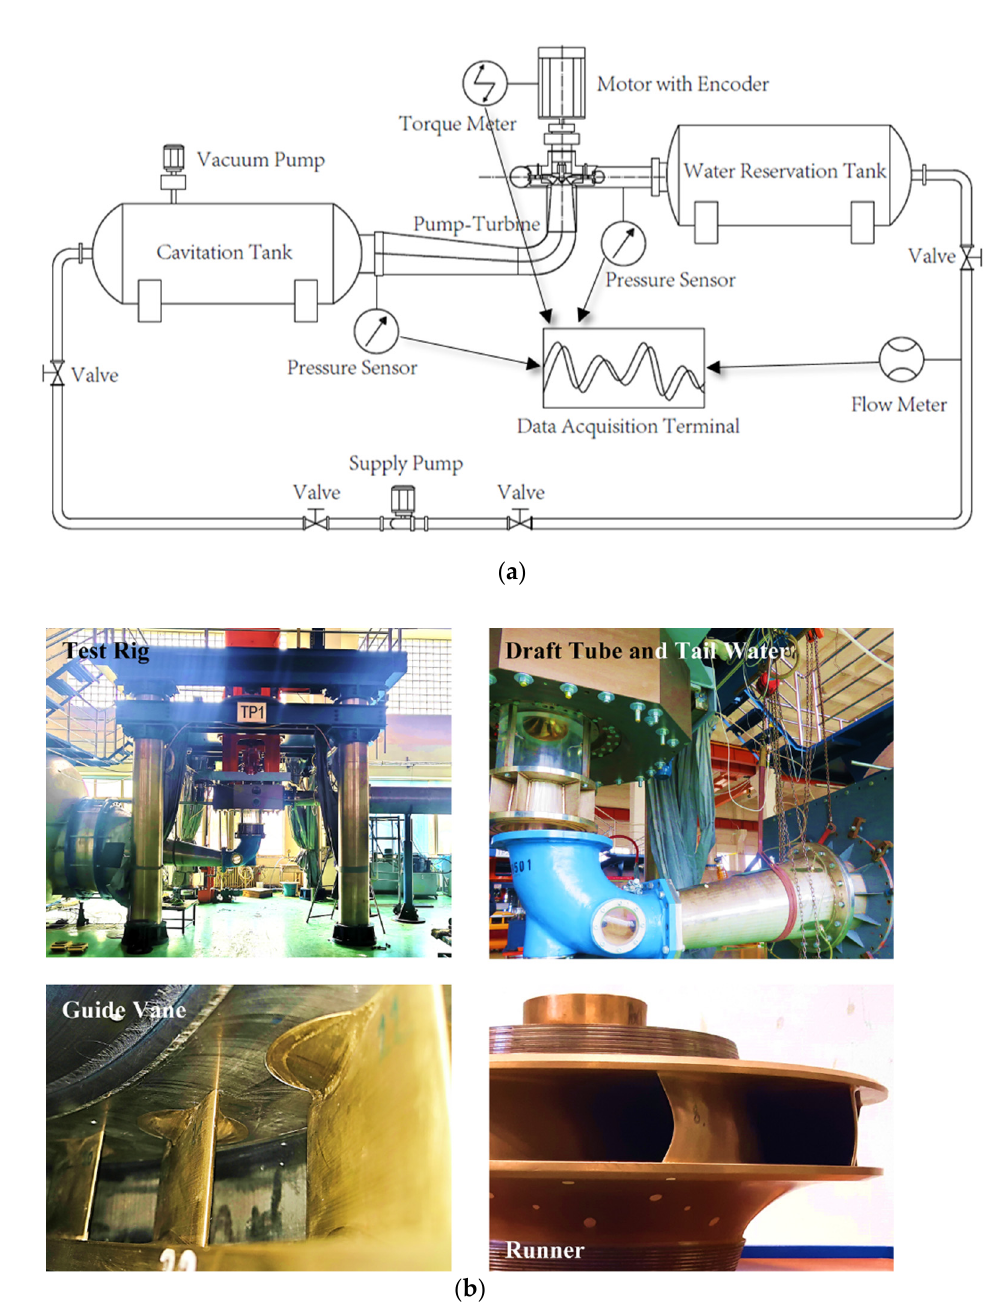
Figure 3. Test rig and apparatus. ( a ) The schematic map of the test rig and apparatus; ( b ) the on-site view of the test rig. Table 3. Measured physical quantities and apparatus uncertainty.